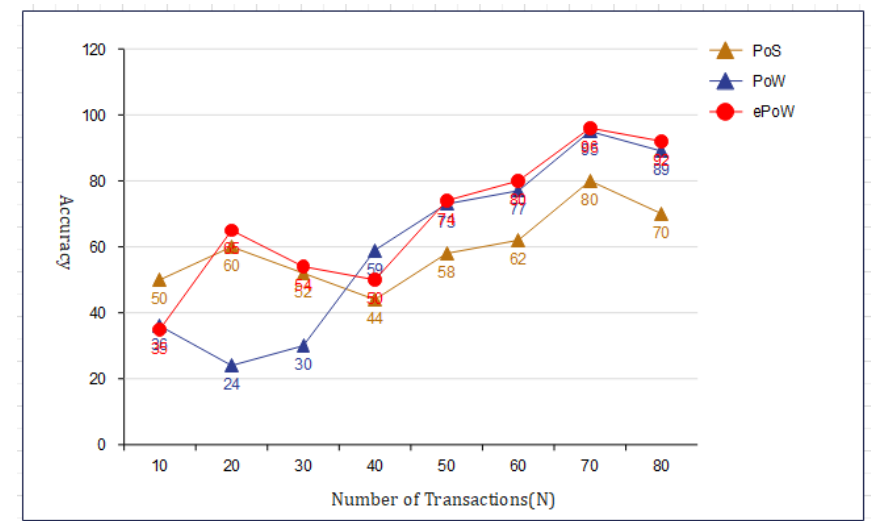
Figure 9. Proposed Neural Network system for fog-computing.